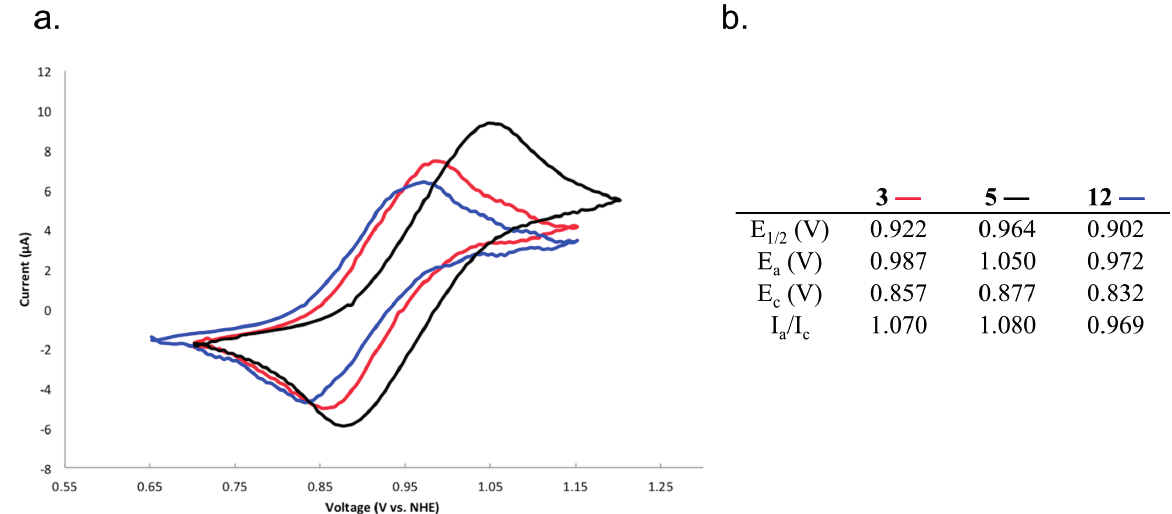
PF in dichloromethane with a scan rate of 100 mV·s − 1 . at 2.0 mM with 0.1 M NBu 4 6 Positive currents correspond to oxidation. Potentials were measured relative to the ferrocenium/ferrocene redox couple as an internal standard, and are reported relative to the NHE; ( b ) Derived electrochemical parameters (see Experimental Section 3.1.